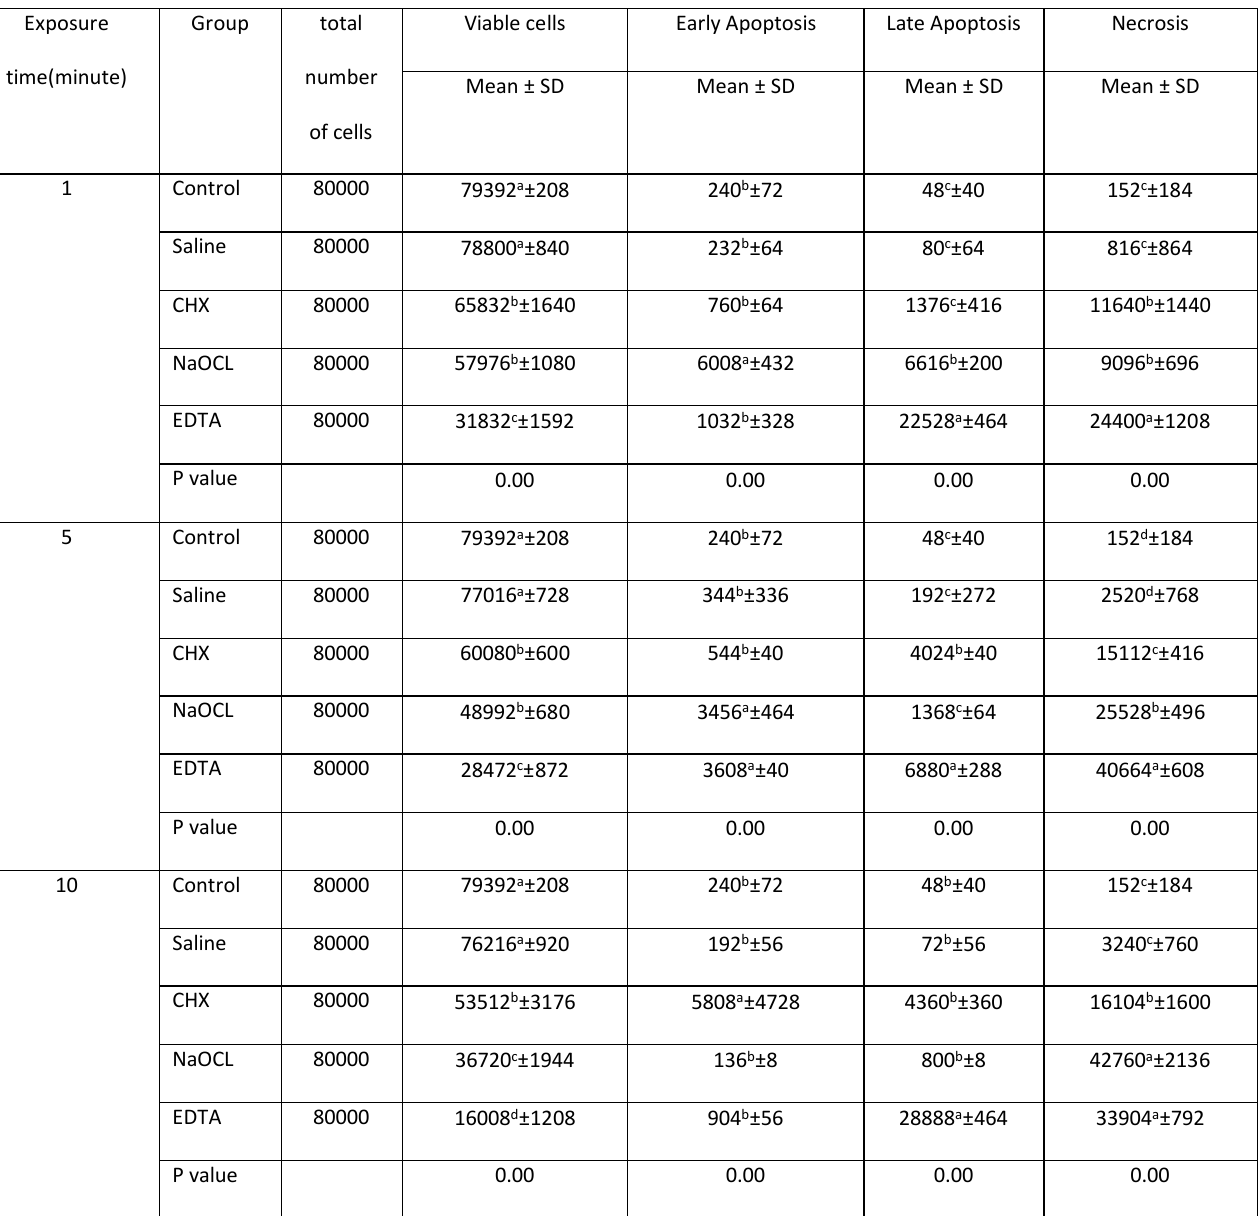
Figure 3. Flow cytometry graph of annexin/pi for EDTA treated PDLSCs: (A) control group, (B) after 1 minute, (C) after 5 minutes, (D) after 10 minutes. In this graph, the upper left (annexin -/ pi +) indicates the necrotic cells, the lower left (annexin -/ pi -) indicates the viable cells, the upper right (annexin +/ pi +) indicates the late apoptotic cells, and the lower right (annexin +/ pi -) indicates the early apoptotic